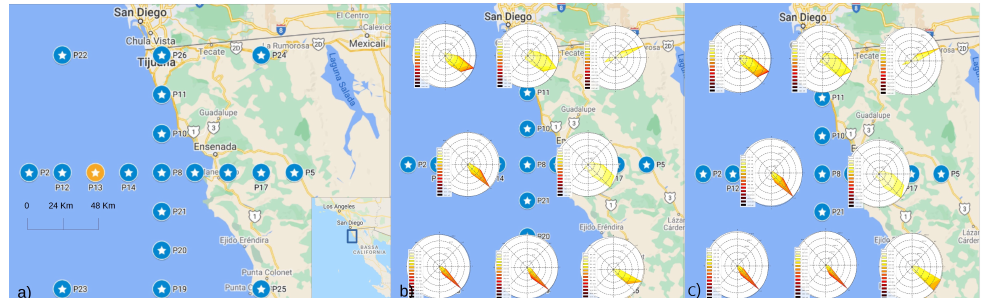
Figure 3. ( a ) Points of the ERA5 meteorological model for which data were downloaded; wind roses produced for eight selected points based on ( b ) the Typical Meteorological Year (TMY) and ( c ) the long-term time series of wind speed and direction. Long-term time series refer to all concatenated wind speed and direction values in the time period considered